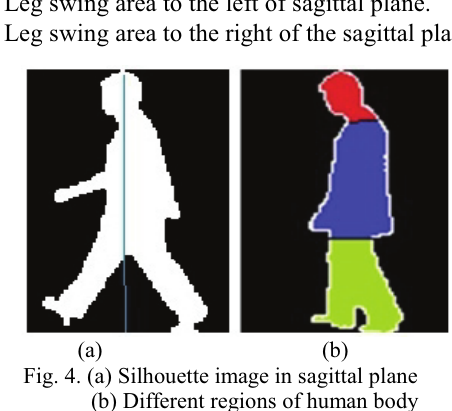
Fig. 4. (a) Silhouette image in sagittal plane